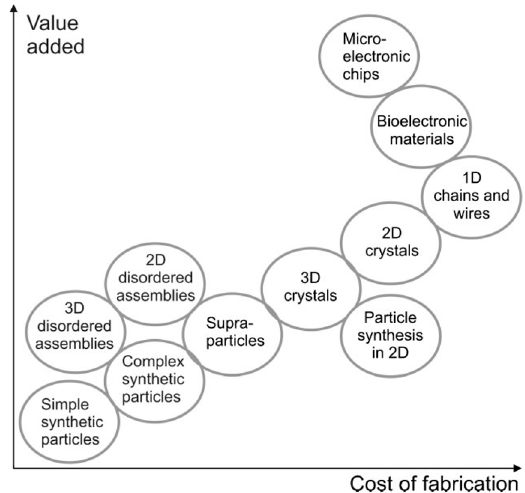
Figure 1. Hypothetical qualitative estimation of the value-to-price ratio for different products gathered by colloidal assembly. Adapted with permission from [4] (p. 7), Copyright 2009 Wiley.